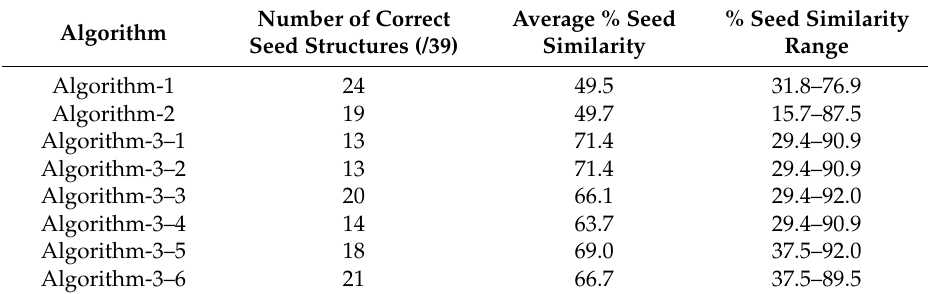
Table 1. Number of correct seed structures generated by different seed generation algorithms.